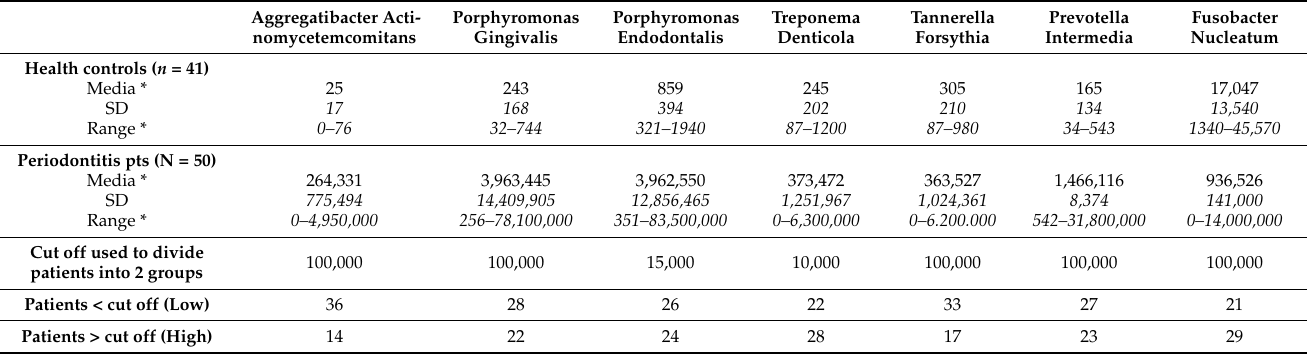
Table 6. Results of the bacterial load by real-time PCR from health controls and periodontitis patients’ samples.